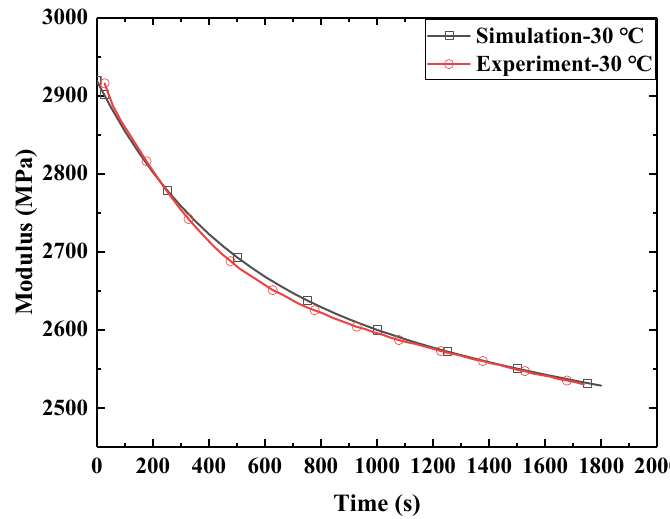
Figure 14. Comparison between uniaxial tension simulation and experimental data.